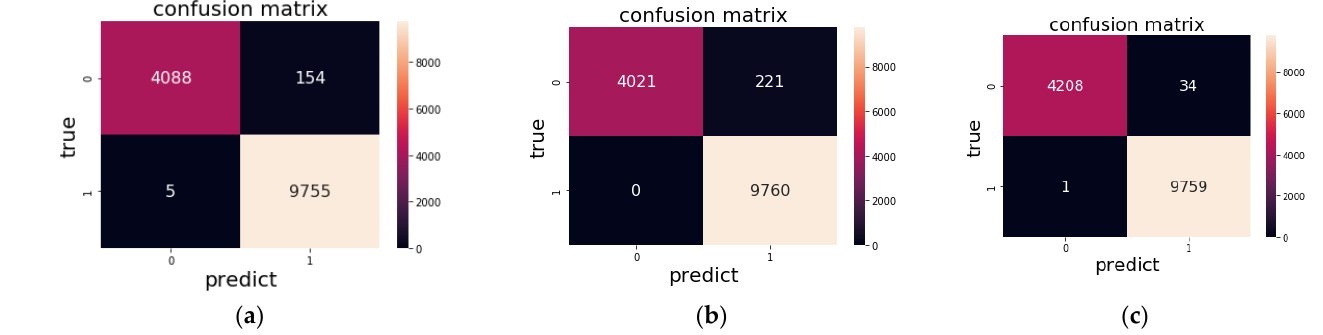
Figure 12. Confusion matrices of different methods. ( a ) STFT+2D-CNN; ( b ) FFT+DNN; ( c ) Time- domain signal+1D-CNN.